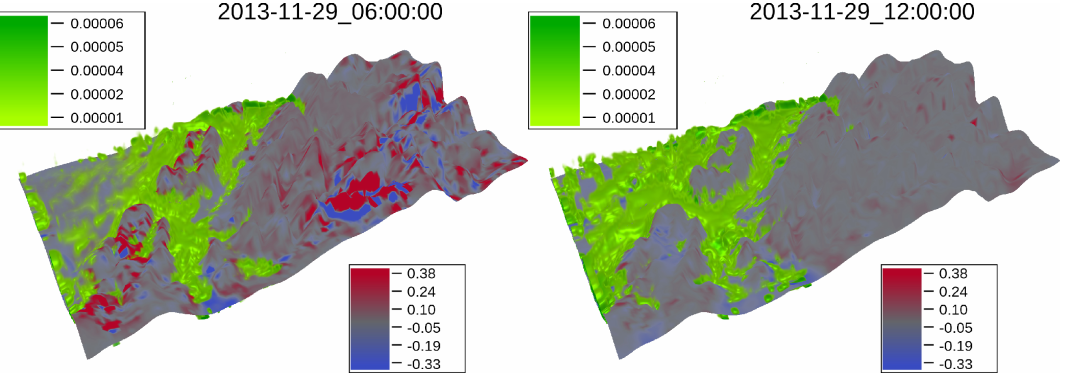
Figure 7. Impact of the on-line coupling on meteorological variables at 1 ⁄ 90 ◦ resolution (GRE0011) on 29 November at 06:00 UTC (left) 12:00 UTC (right). Color palettes represent the difference between CPL01 and REF01 simulations (green for the cloud water content in kg kg − 1 , blue to red the 2 m temperature in ◦ C). Imagery produced by VAPOR (www.vapor.ucar.edu), a product of the Computational Information Systems Laboratory at the National Center for Atmospheric Research [71]